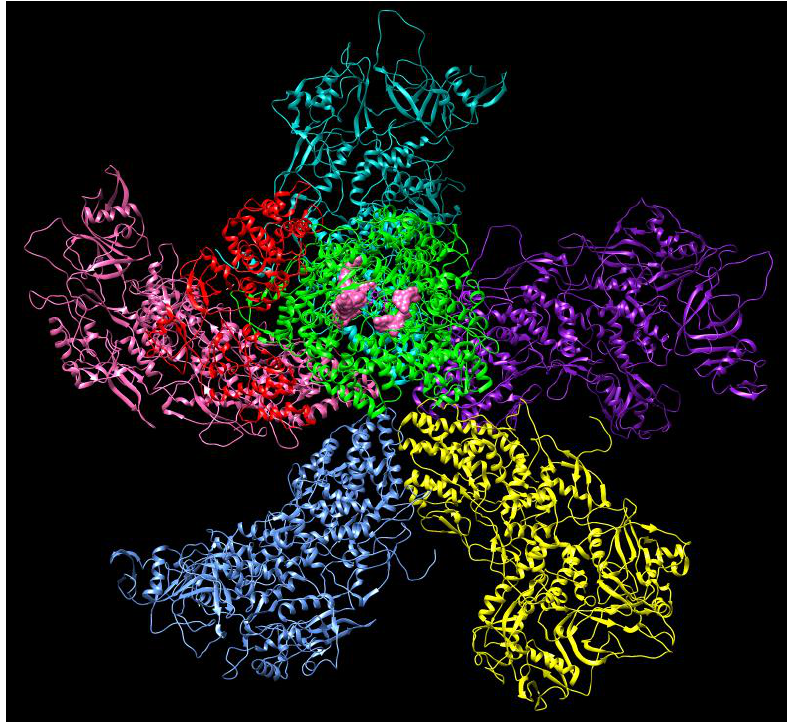
Figure 2. The structure of the RNA-dependent RNA polymerase (RdRp) complexes in the dinucleotide primed state a dsRNA virus (PDB: 6K32 RdRp complex). Chain A is shown as green, chain B is shown as red, chain C is highlighted in cyan, chain D is highlighted in pink, chain E is highlighted in blue, chain F is highlighted in yellow, chain G is highlighted in purple, chain P is highlighted in magenta and chain T is highlighted in orange. The structures demonstrate the interaction between the nucleotide substrates shown in pink and the conserved residues during the RdRp initiation, and the coordinated conformational changes preceding the elongation stage during replication.